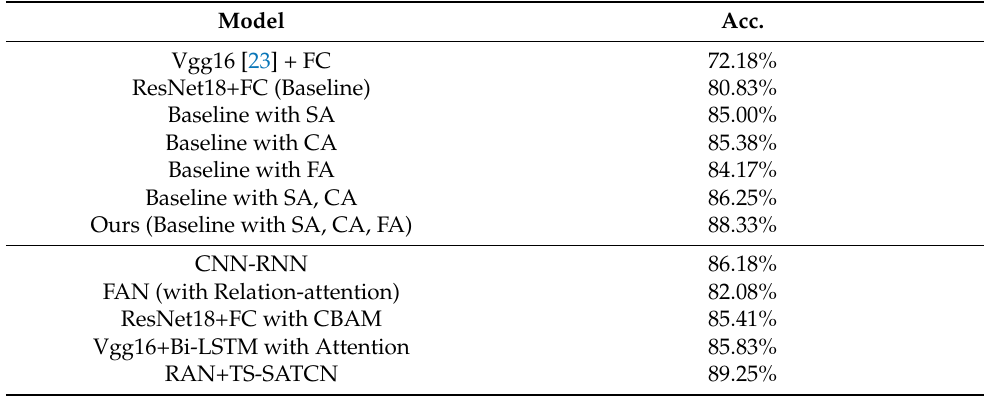
Table 2. Evaluation on the eNTERFACE’05 datasets of the recognition accuracy under different atten- tion modules and comparison of the performances of our method and state-of-the-art FER